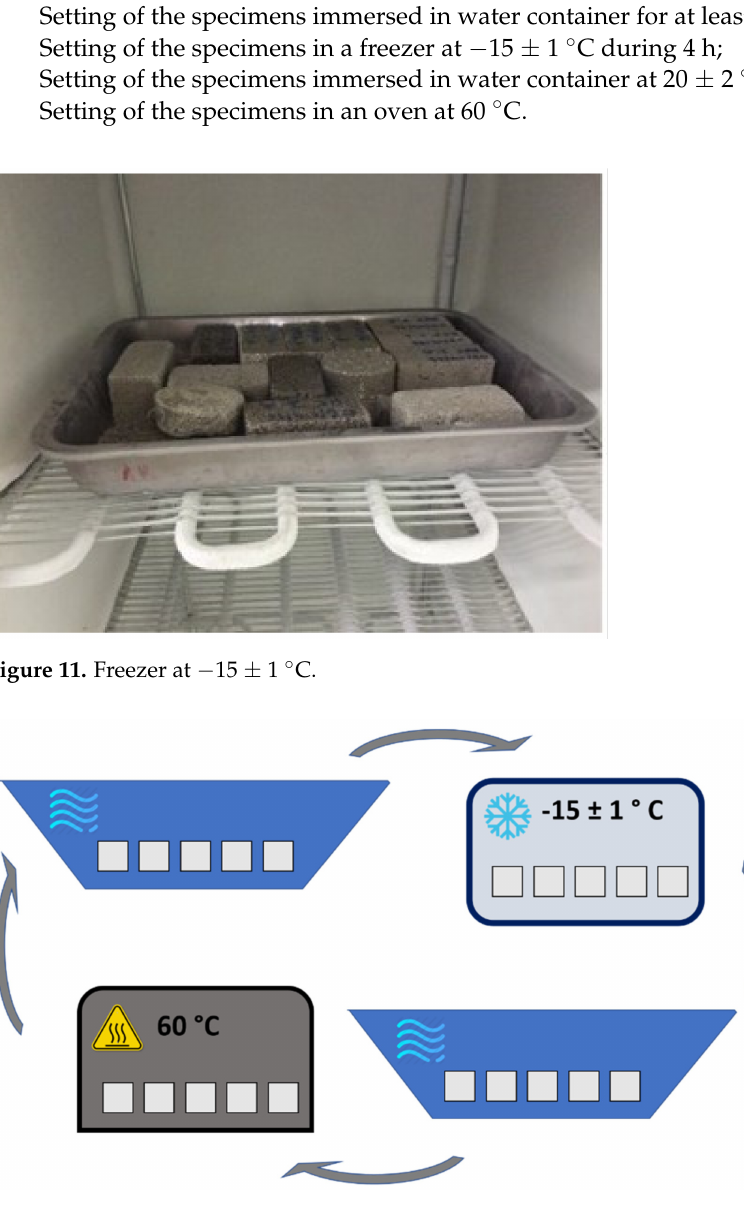
Figure 12. Schematic representation of a Freeze/Thaw cycle. The cycle described above is repeated until a mass variation of more than 30% was obtained, or at a maximum of 20 cycles